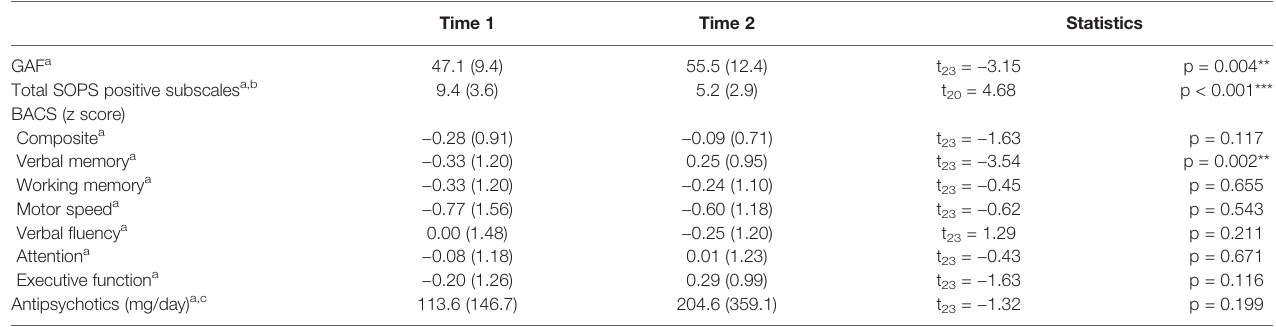
TABLE 2 | Longitudinal changes in clinical characteristics in individuals at